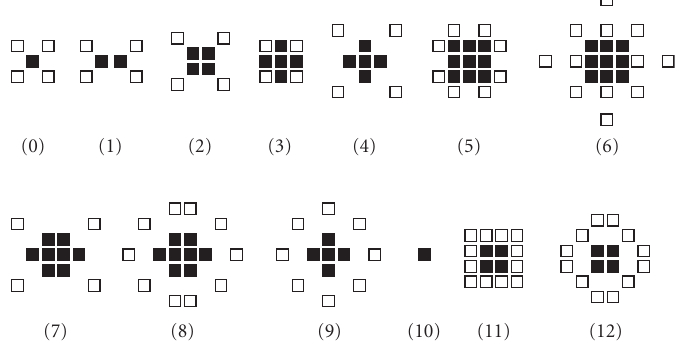
Figure 1: Di ff erent laplace “apertures” tested for on-line flash recognition algorithms. Full black squares denote image pixels added with positive signs and opened squares denote those which are subtracted with proper weight.